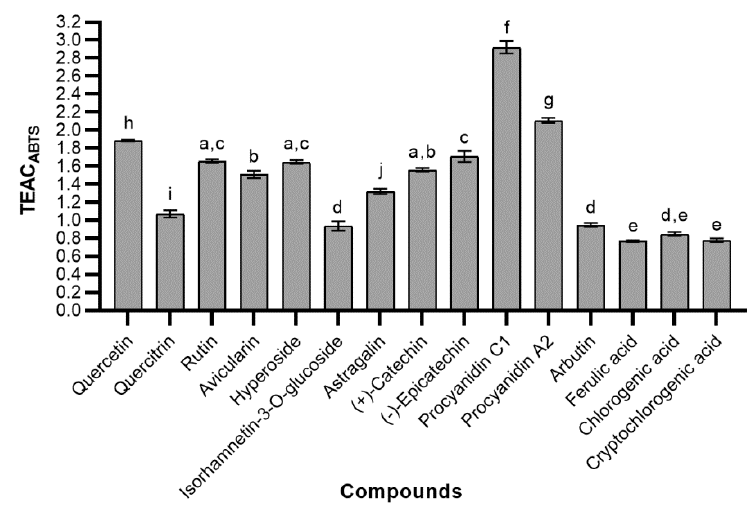
Figure 6. The radical scavenging activity of tested phenolic compounds; bars without the same letters (a, b, c, d, e, f, g, h, i, j) indicate statistically significant differences between the means ( p < 0.05).